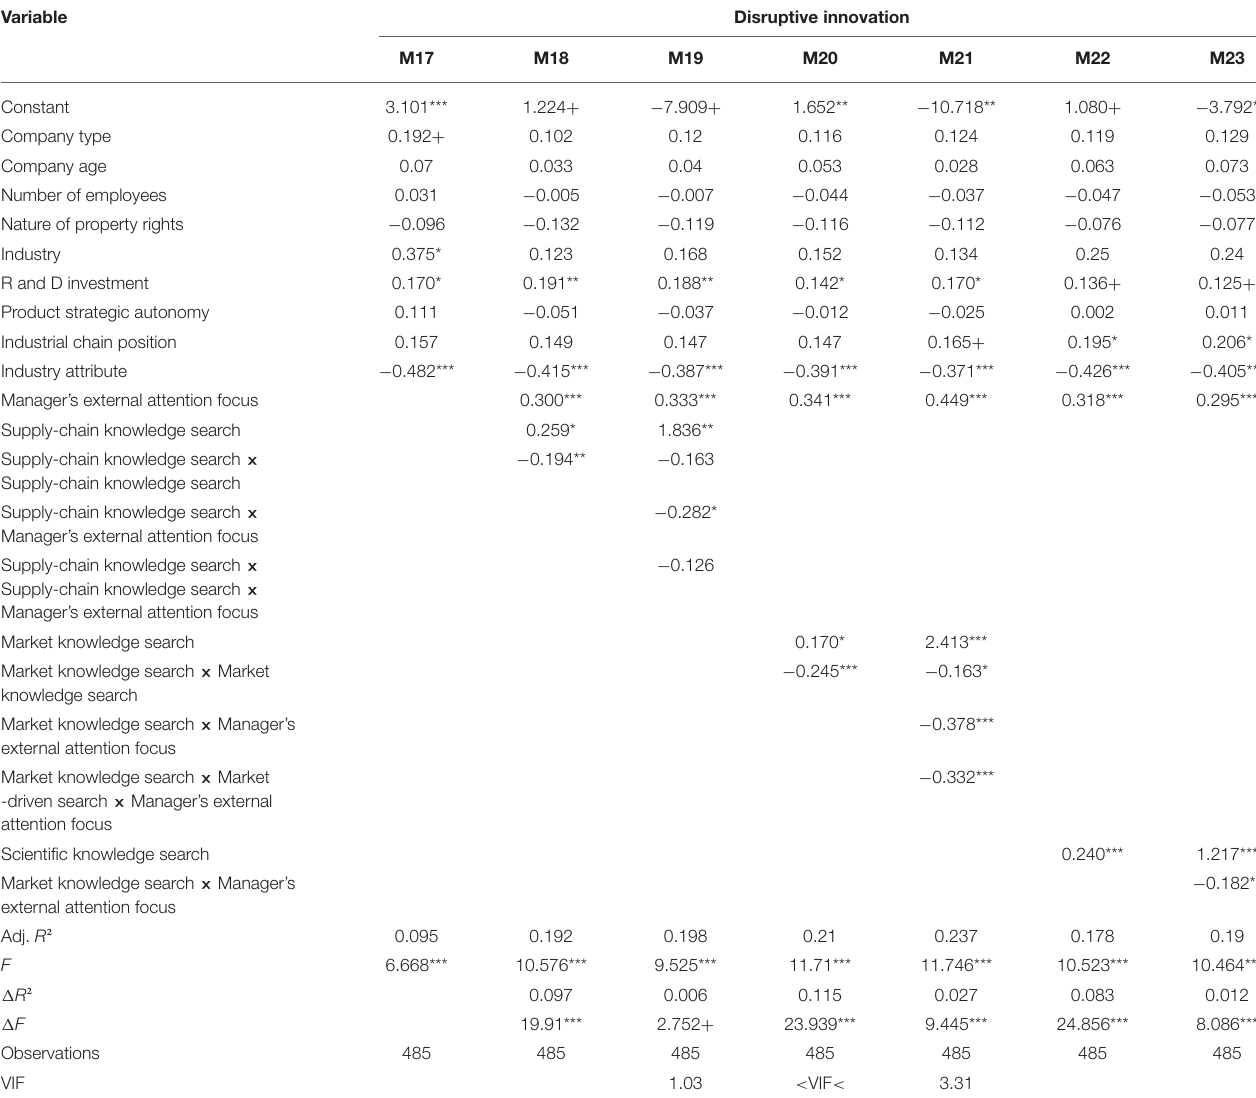
TABLE 8 | Moderating effect of manager’s external attention